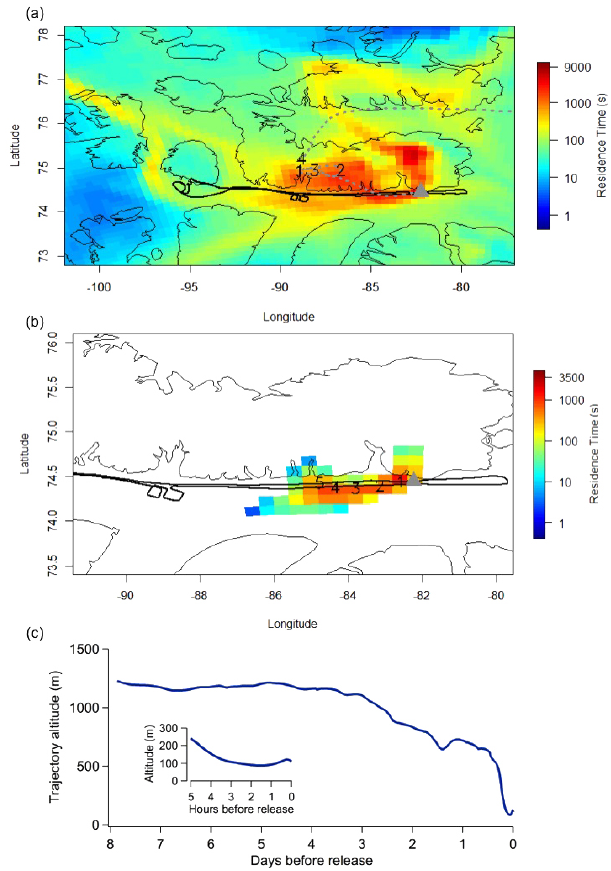
Figure 3. (a) Total column air mass residence time predicted by FLEXPART-WRF, indicating the origin of air sampled along the flight track. The aircraft location at the time of the FLEXPART- WRF particle release is indicated with a grey triangle (74.4 ◦ N, 82.2 ◦ W; ∼ 85ma . g . l . ; 20:39:25UTC). The colour scale represents the residence time of air, in seconds, at a particular location be- fore arriving at the aircraft position. The plume centroid location is shown with a grey dashed line. Numbers indicate the plume centroid location, in days prior to release. (b) Partial column (below 300m) PES predicted by FLEXPART-WRF shown as residence time in sec- onds for particles released at the aircraft location in panel (a) . The colour scale shows the residence time of particles for 5h prior to the release time and below 300m. Numbers indicate the plume centroid location, in hours prior to release. (c) Plume centroid altitude 8 days prior to release and 5h prior to release (inset).